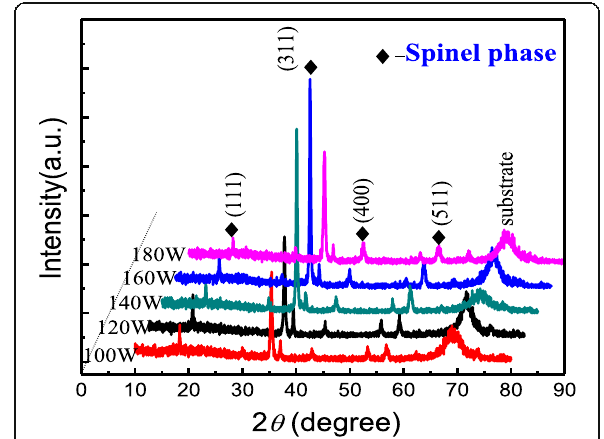
Fig. 1 XRD patterns of samples on p-Si(100) substrate and sputtered under different RF magnetron sputtering powers 100, 120, 140, 160, and 180 W